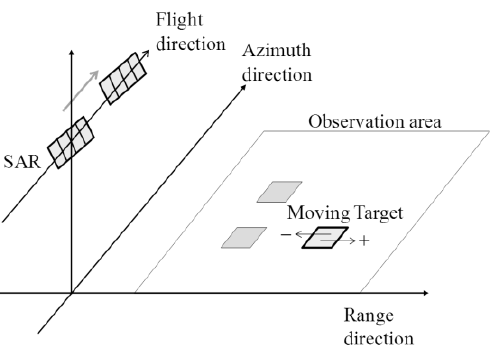
Figure 5. Schematic image of stationary and moving